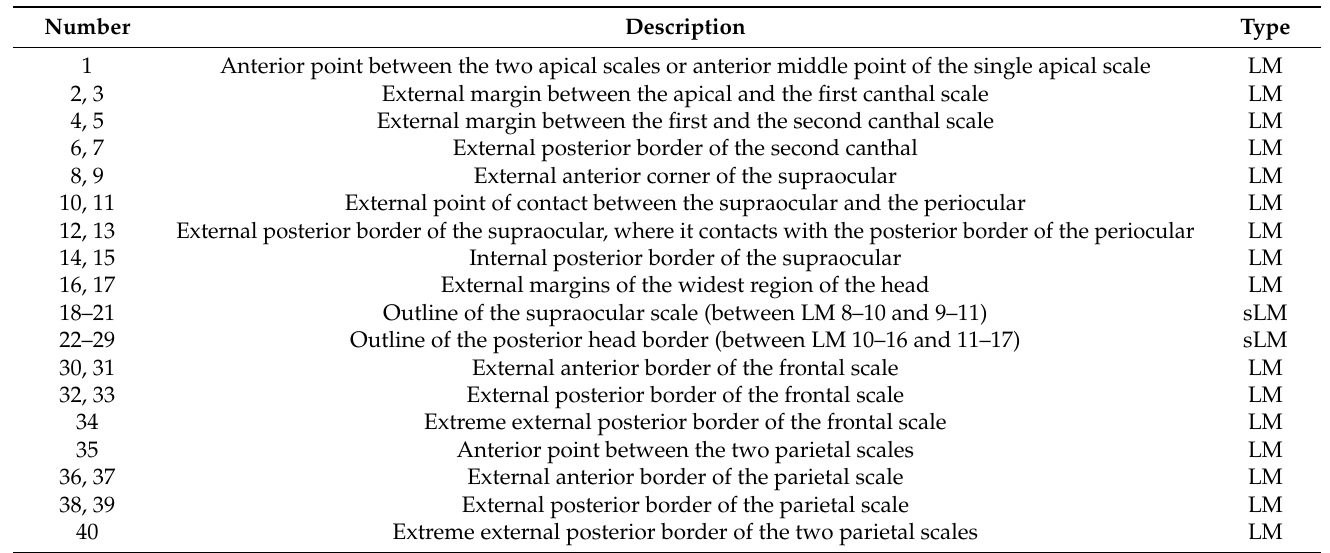
Table 1. Descriptions of the position of landmarks (LM) and semi-landmarks (sLM) used to quantify the head shape in Vipera ursinii . Paired numbers represent landmarks at the right and left sides of the head,